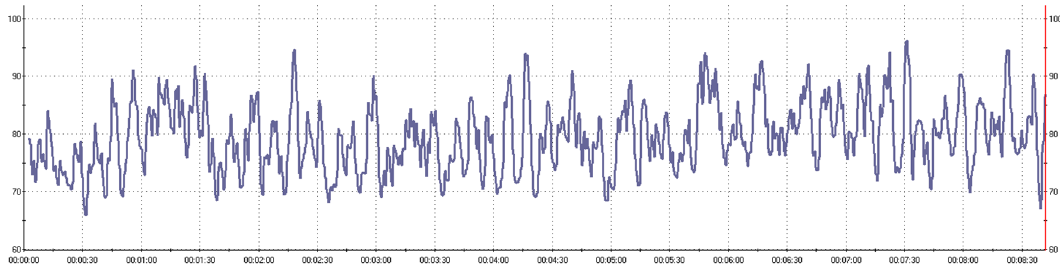
Figure 9. Bio-data—Tracking subject’s heart rate during experiment session.